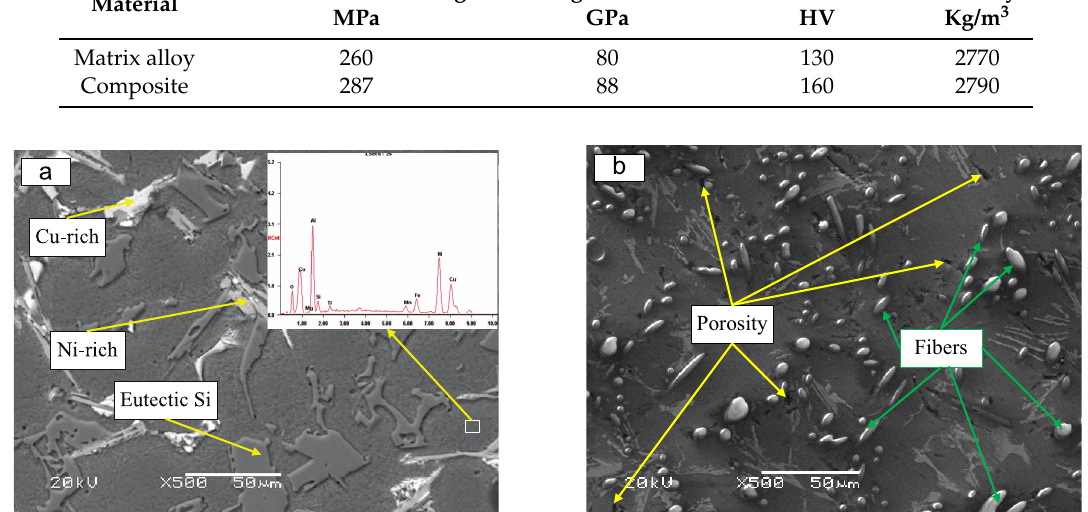
Figure 1. Microstructure of the ( a ) Al–12Si–CuNiMg matrix alloy and ( b ) 17 vol.% Al 2 O 3 fiber-reinforced composite.